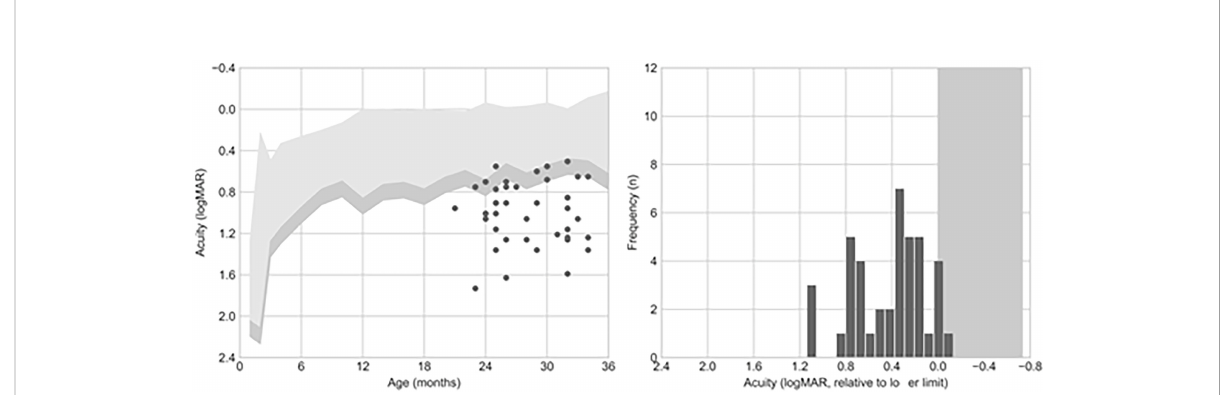
FIGURE 1 Visual acuity (VA) outcomes. The left panel shows the comparison of VA to the normative values published by Salomão and Ventura (1995). The right panel shows acuity as an offset from the mean acuity for the patient ’ s age. Six out of 41 (15%) patients presented an acuity value falling below this